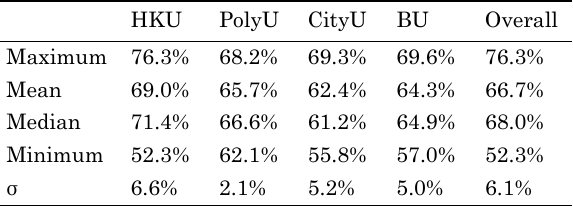
Table 5. Summary statistics of the PDIS assessment